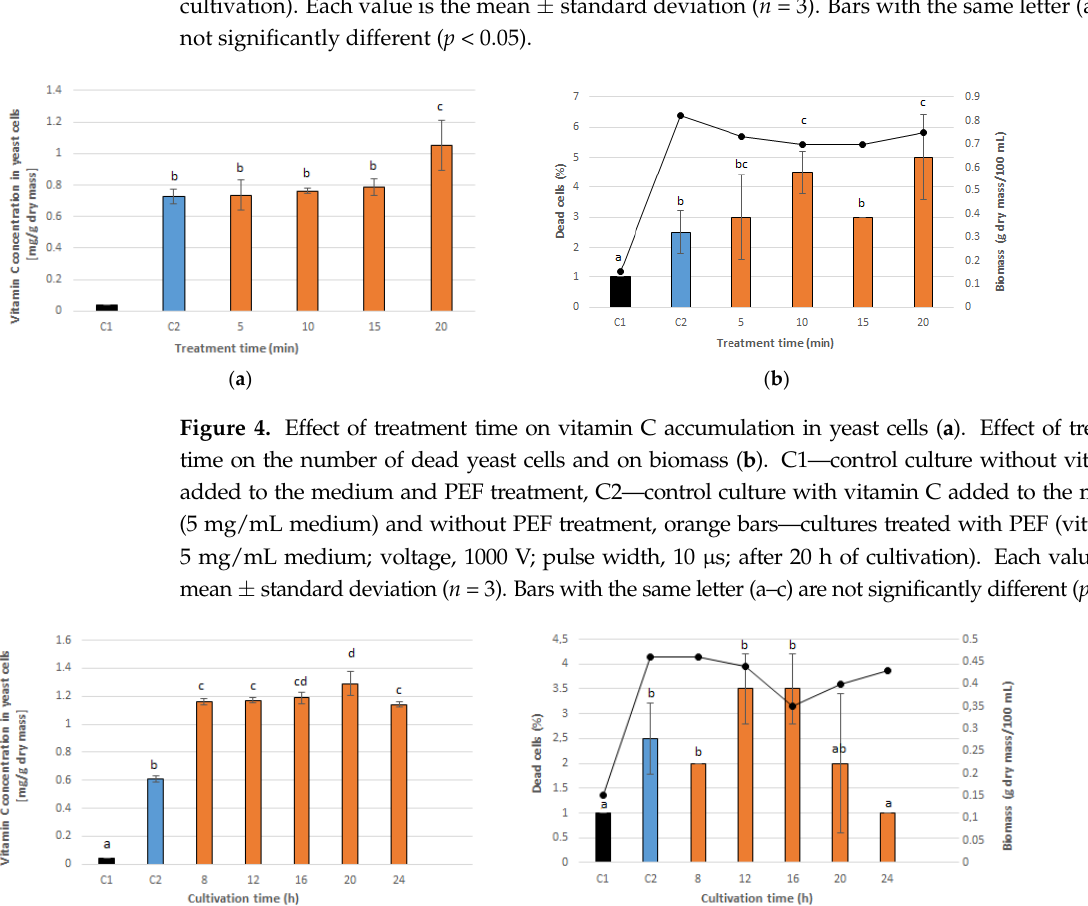
Figure 4. Effect of treatment time on vitamin C accumulation in yeast cells ( a ). Effect of treatment time on the number of dead yeast cells and on biomass ( b ). C1—control culture without vitamin C added to the medium and PEF treatment, C2—control culture with vitamin C added to the medium (5 mg/mL medium) and without PEF treatment, orange bars—cultures treated with PEF (vitamin C, 5 mg/mL medium; voltage, 1000 V; pulse width, 10 µs; after 20 h of cultivation). Each value is the Figure 3. Effect of pulse width on vitamin C accumulation in yeast cells ( a ). Effect of pulse width on Figure 3. Effect of pulse width on vitamin C accumulation in yeast cells ( a ). Effect of pulse width the number of dead yeast cells and on biomass ( b ). C1—control culture without vitamin C added to mean ± standard deviation ( n = 3). Bars with the same letter (a–c) are not significantly different ( p < on the number of dead yeast cells and on biomass ( b ). C1—control culture without vitamin C the medium and PEF treatment, C2—control culture with vitamin C added to the medium (5 mg/mL 0.05). Figure 3. Effect of pulse width on vitamin C accumulation in yeast cells ( a ). Effect of pulse width on medium) and without PEF treatment, orange bars—cultures treated with PEF (vitamin C, 5 mg/mL added to the medium and PEF treatment, C2—control culture with vitamin C added to the medium the number of dead yeast cells and on biomass ( b ). C1—control culture without vitamin C added to medium; voltage, 1000 V; treatment time, 10 min; number of pulses, 600; after 20 h of cultivation). (5 mg/mL medium) and without PEF treatment, orange bars—cultures treated with PEF (vitamin C, the medium and PEF treatment, C2—control culture with vitamin C added to the medium (5 mg/mL Each value is the mean ± standard deviation ( n = 3). Bars with the same letter (a–d) are not signifi- medium) and without PEF treatment, orange bars—cultures treated with PEF (vitamin C, 5 mg/mL cantly different ( p < 0.05). 5 mg/mL medium; voltage, 1000 V; treatment time, 10 min; number of pulses, 600; after 20 h of medium; voltage, 1000 V; treatment time, 10 min; number of pulses, 600; after 20 h of cultivation). cultivation). Each value is the mean ± standard deviation ( n = 3). Bars with the same letter (a–d) are Each value is the mean ± standard deviation ( n = 3). Bars with the same letter (a–d) are not signifi- not significantly different ( p < 0.05). cantly different ( p < 0.05).